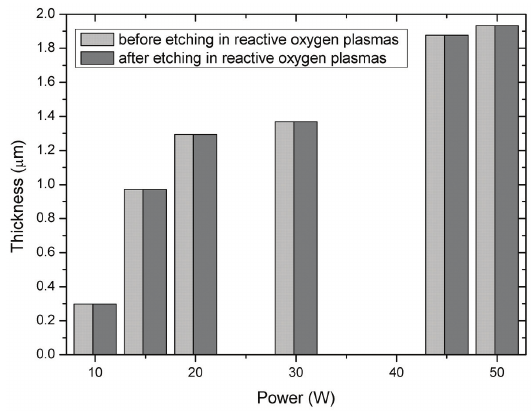
Figure 25. Thickness of the films before and after etching in reactive oxygen plasma as a function of the depositing plasma